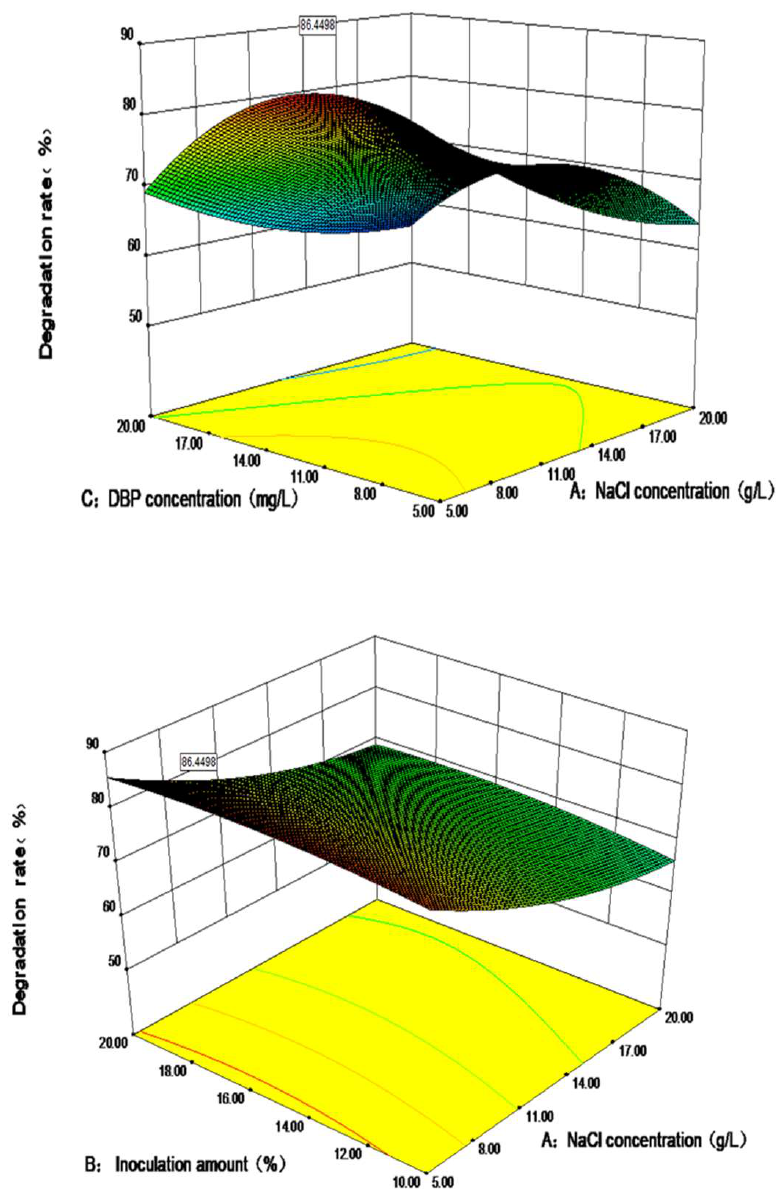
Figure 4. Response surface graph on the DBP degradation rate of Acinetobacter baumannii DP-2.